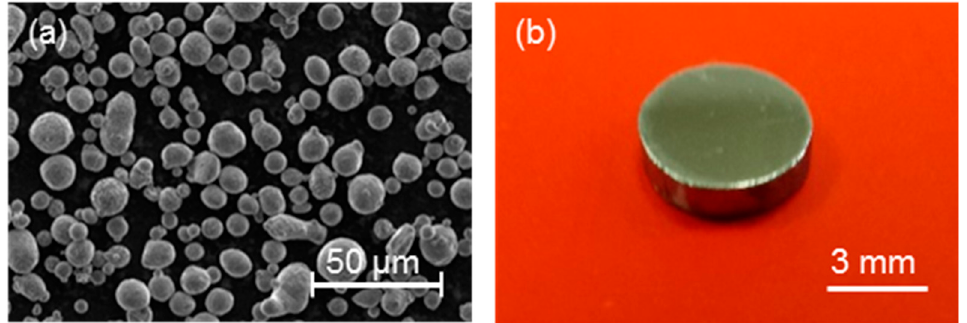
Figure 2. ( a ) Morphology of the original aluminum powder. ( b ) Bulk aluminum specimen sintered by UAS under pneumatic pressure of 600 kPa.